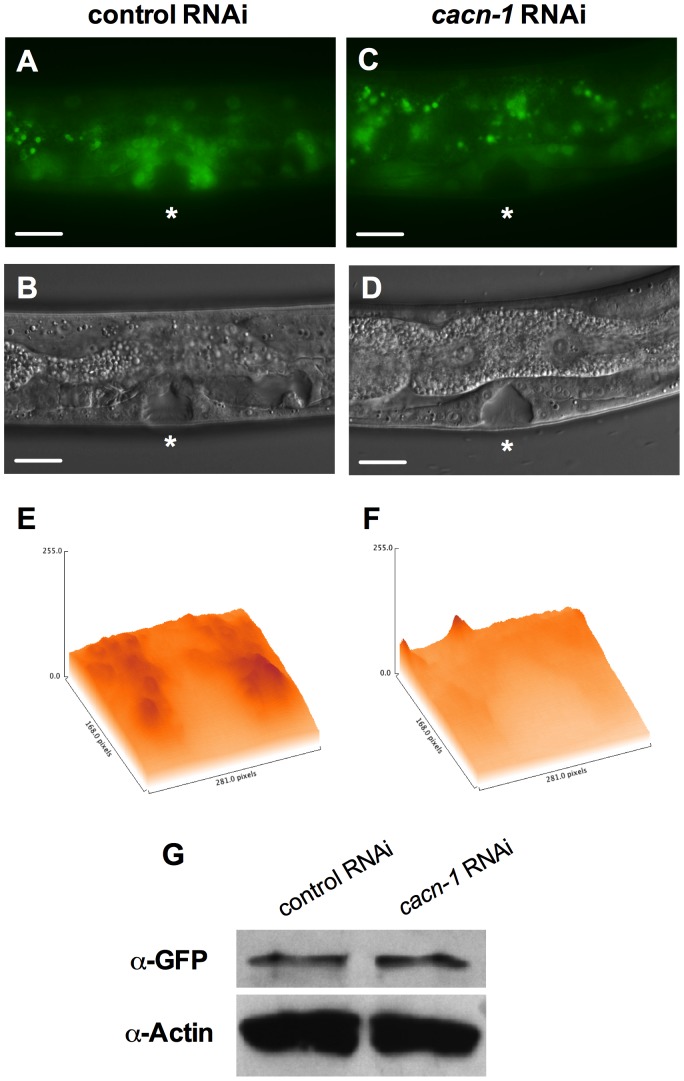

cacn-1 RNAi reduces LIT-1::GFP expression.LIT-1::GFP animals were grown on E. coli HT115(DE3) carrying (A, B) control RNAi or (C, D) cacn-1 RNAi vector. Asterisks indicate L4 developing vulva. 3-dimensional representations of GFP expression with peak height corresponding to maximum intensity of fluorescent reporter in the uterus and vulva of (E) control RNAi or (F) cacn-1 RNAi treated animals. (G) Western blots of extracts from control RNAi or cacn-1 RNAi-treated LIT-1::GFP animals were probed with anti-GFP (LIT-1::GFP) and anti-Actin antibodies. Scale bar is 25 µm.